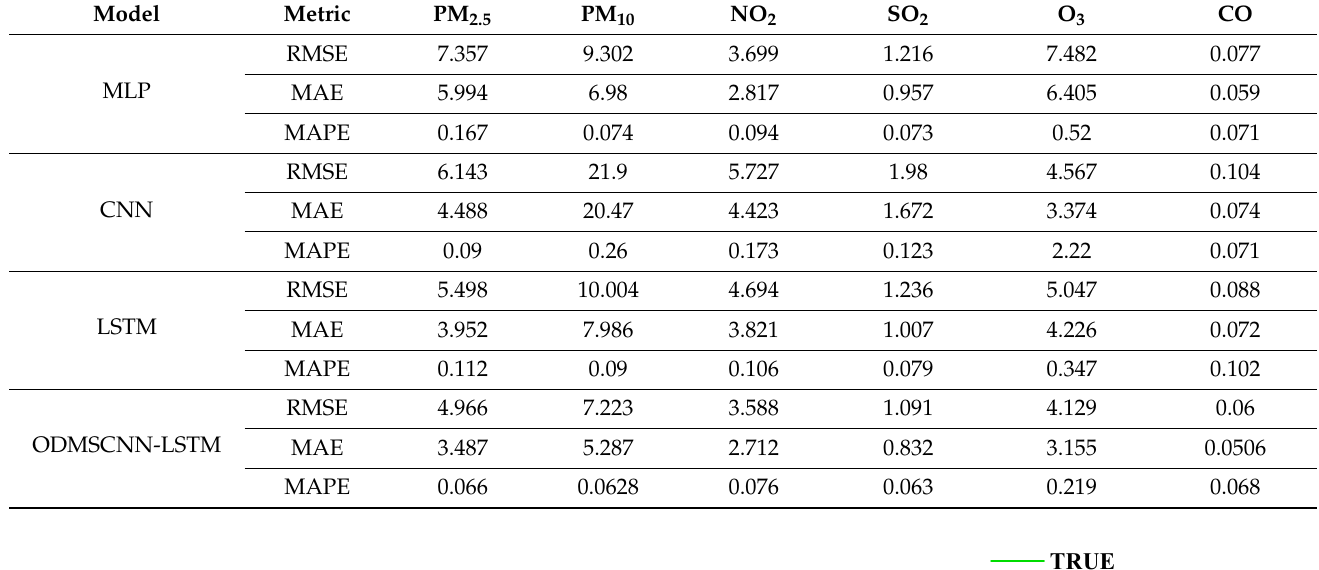
Table 3. Using hourly concentration data to predict, the prediction performance comparison of MLP, CNN, LSTM and ODMSCNN-LSTM models.